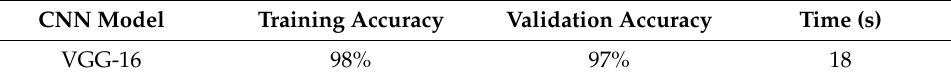
Table 4. Training and validation accuracies and training time for one epoch.